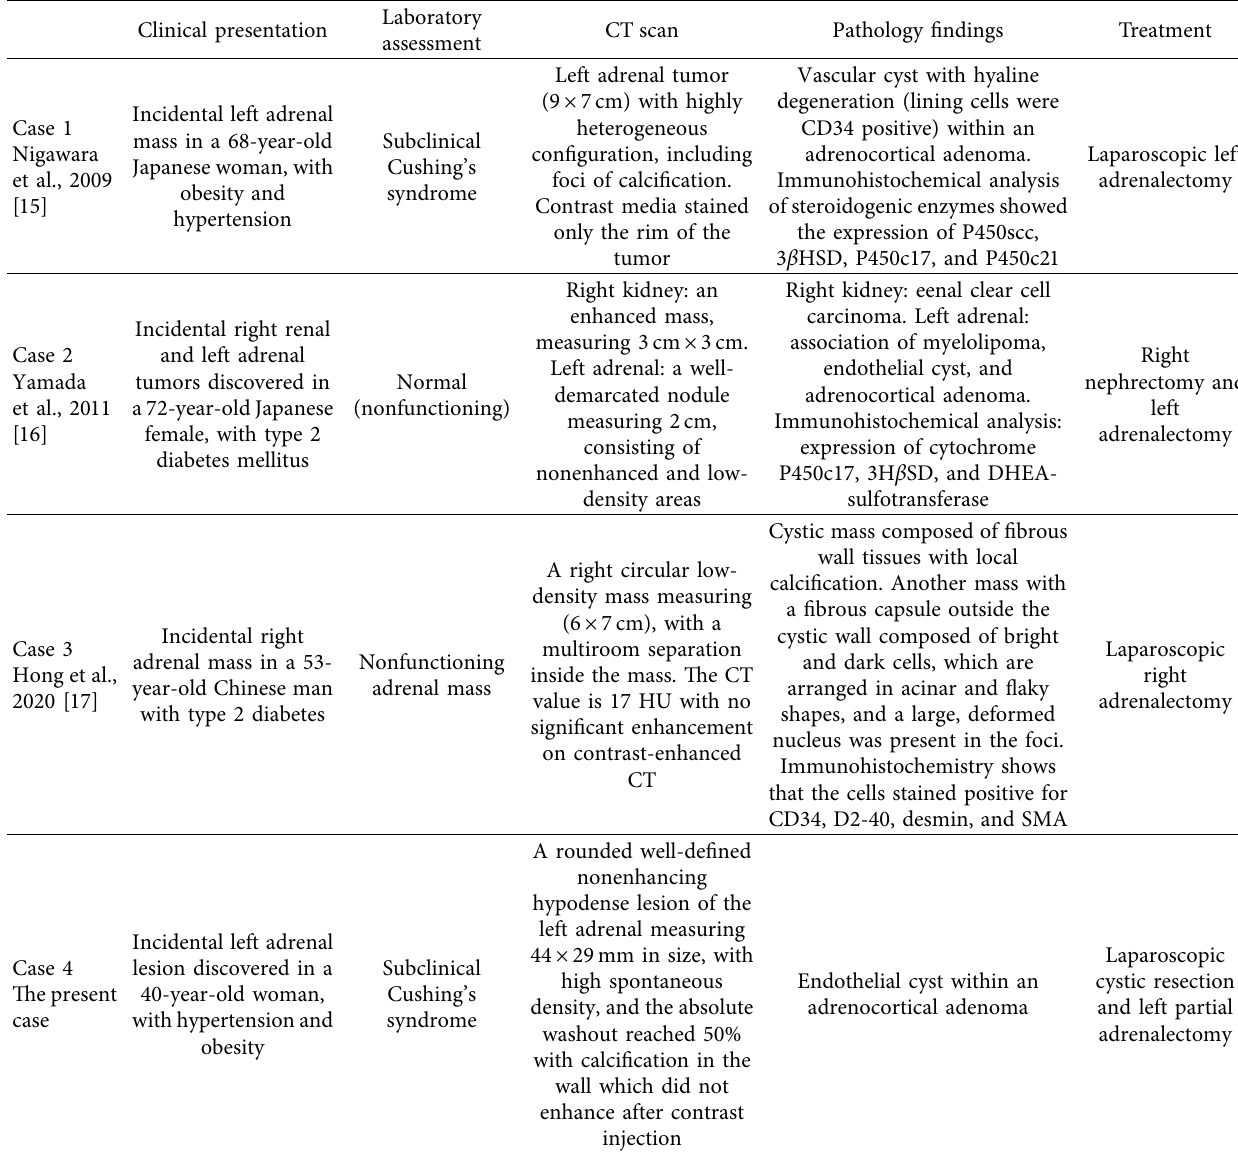
Table 3: Comparative table of the previous cases and the present